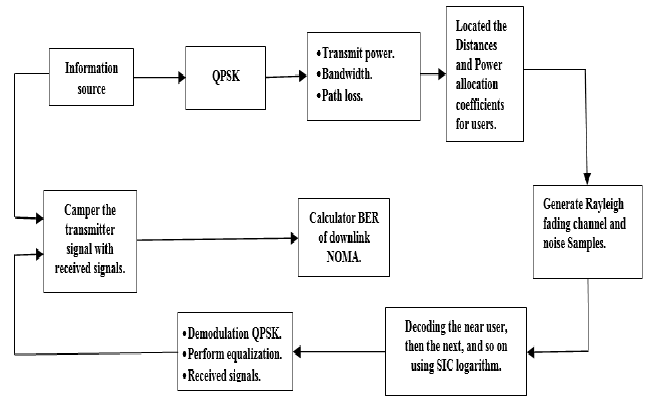
Figure 1. Block diagram for steps of downlink NOMA and calculate the